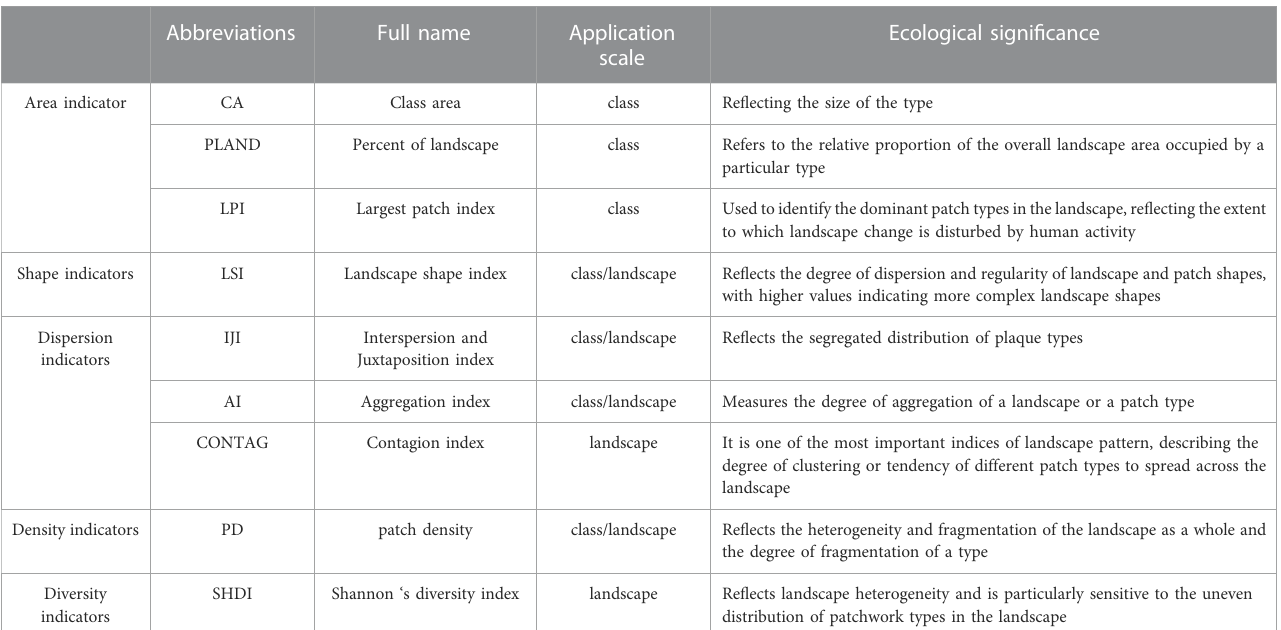
TABLE 1 Selection of landscape pattern indices and their ecological signi fi